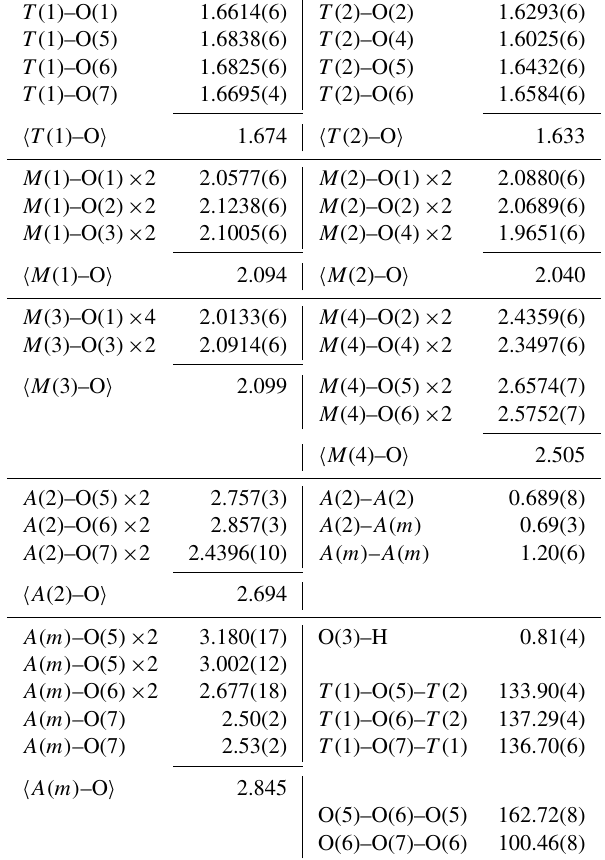
Table 6. Selected interatomic distances (Å) and angles ( ◦ ) in ferri- taramite.